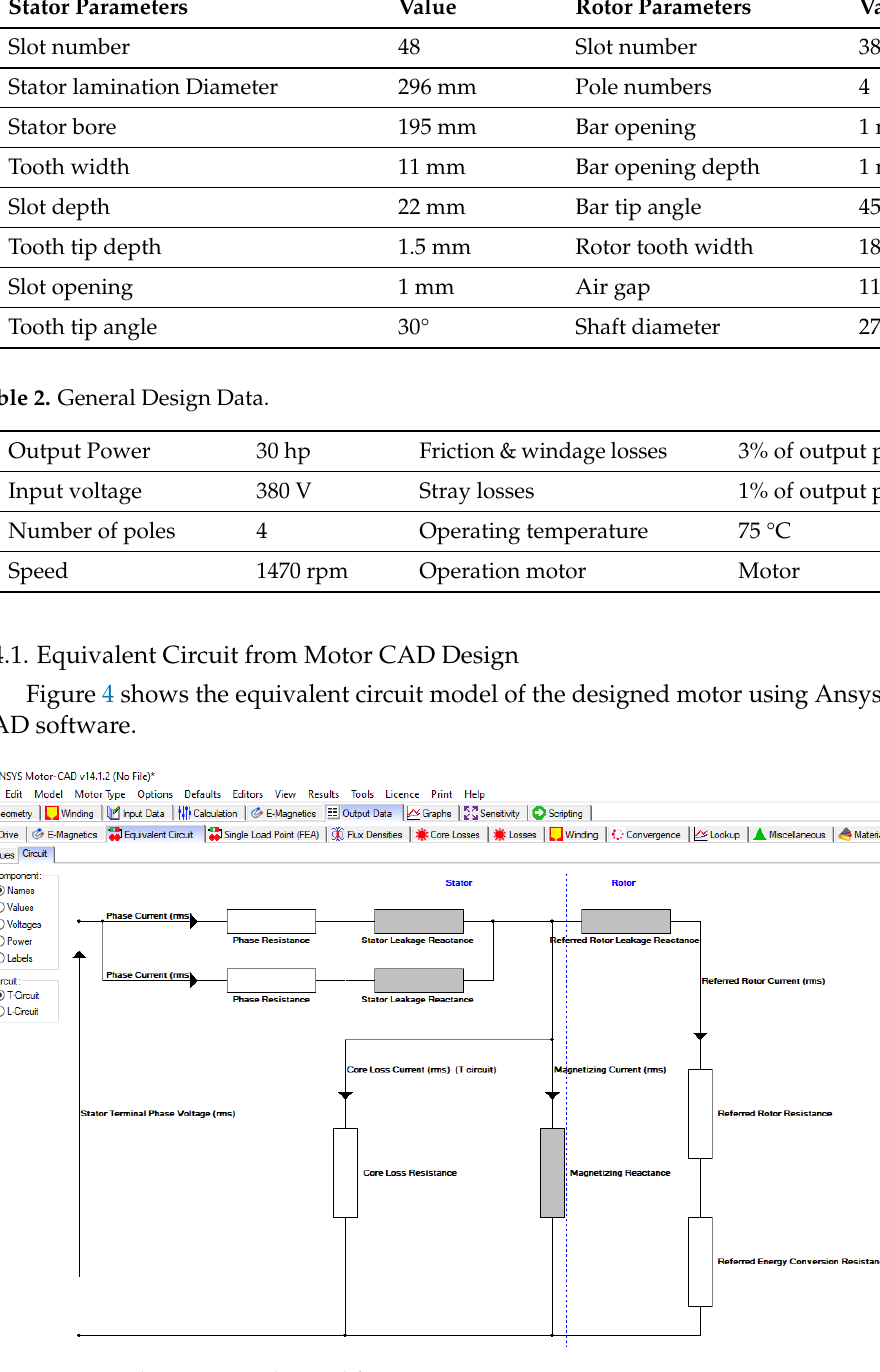
Figure 4. Equivalent Circuit Obtained from ANSYS